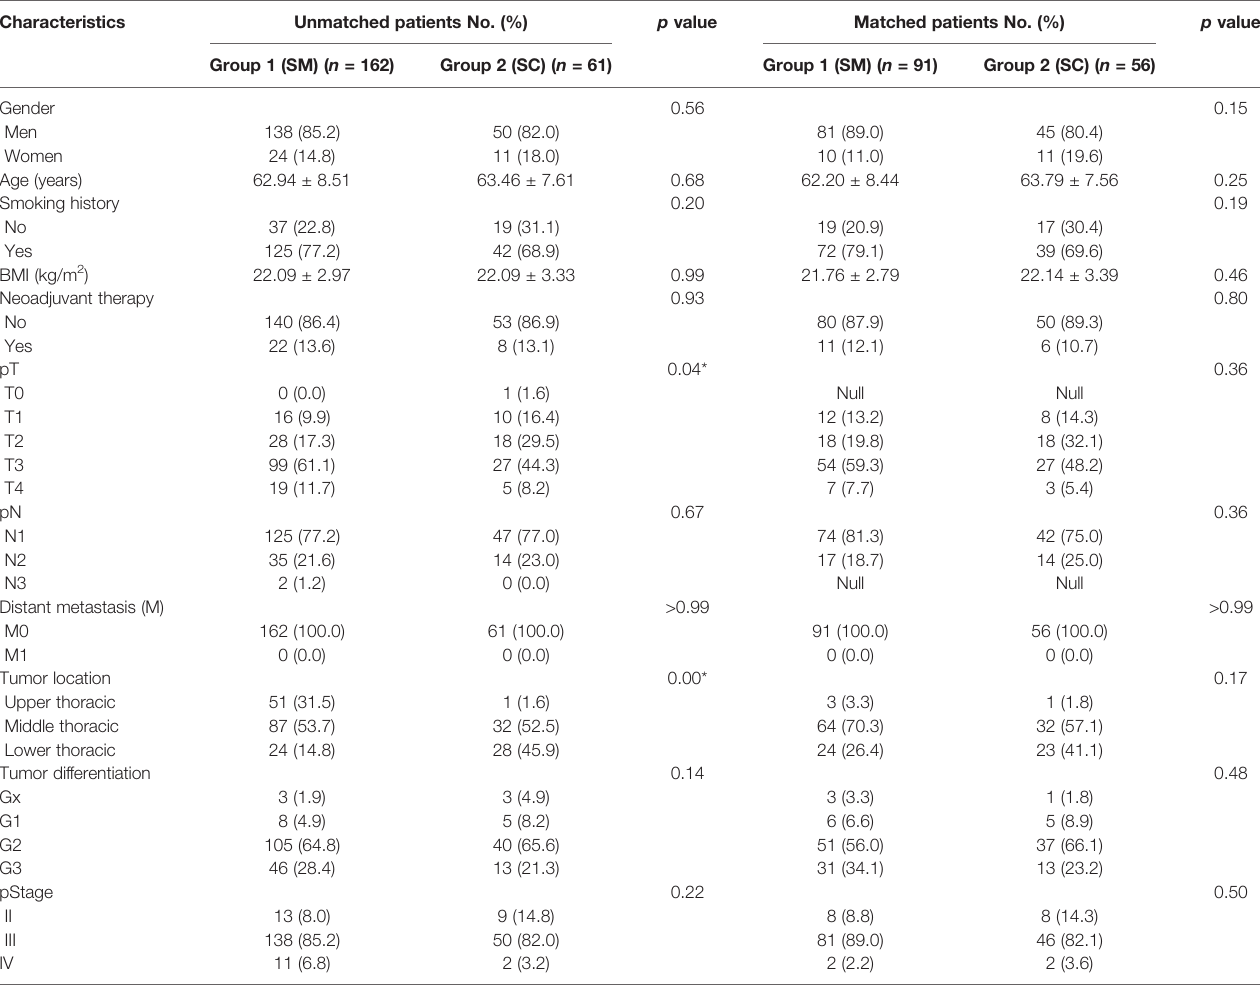
TABLE 1 | Clinical and other relevant patient characteristics before and after propensity score matching.